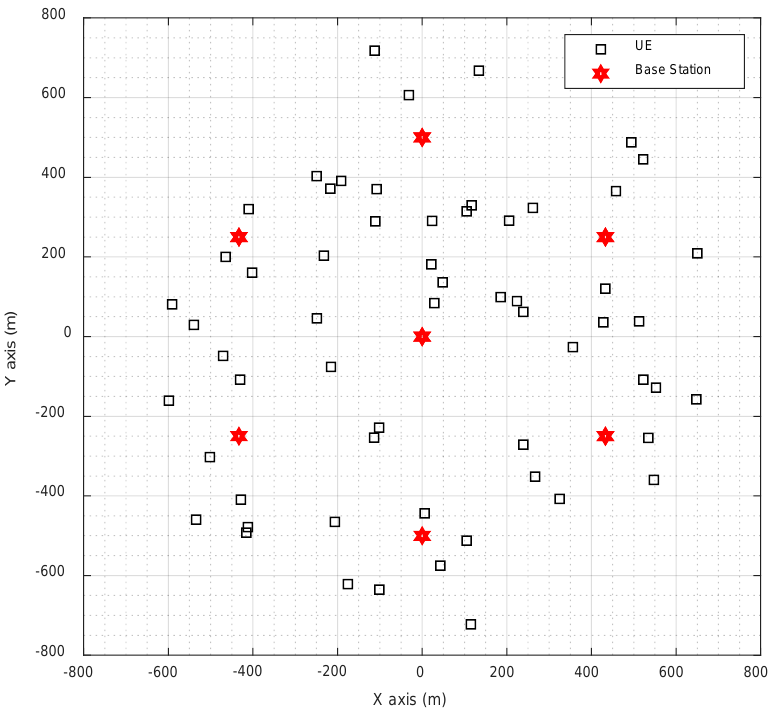
Figure 5. The distribution of base station and UE in UMa scenario.